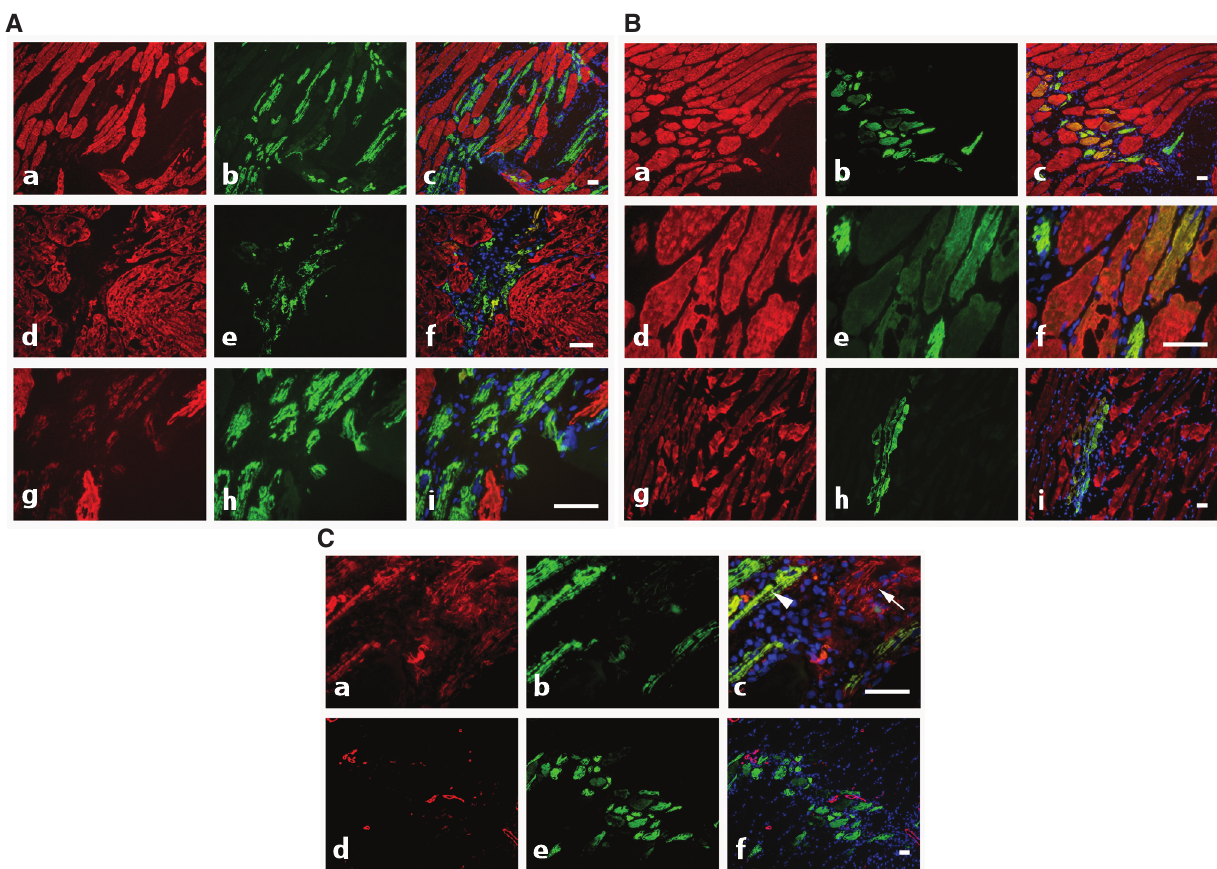
Figure 3. Regenerating rat adult skeletal muscle co-stained with isoform specific antibodies. A ) At 4d post-injury, co-staining with anti- α -SKA (red) and anti- α -CAA (green) shows the presence of α -CAA positive fibers in the injured muscle area (a–i). At this stage of regeneration, only a few fibers co-express both isoforms (d–i), with a low α -SKA level (g–i). Merged images are shown on right column. Bars = 50 μm. B ) At 5d–9d post-injury, co-staining with anti- α -SKA (red) and anti- α -CAA (green) shows that after 5d, most fibers co-express both isoforms (a–f), whereas at 9d (g–i), α -SKA positive fibers become predominant. Merged images are shown on right column. Bars = 50 μm. C ) At 4d–5d post-injury, co-staining with anti- α -SMA (red) and anti- α -CAA (green) shows that during the healing process, only a few fibers co-express both isoforms after 4d (a–c, arrowhead), whereas after 5d, only α -CAA positive fibers are detected (d–f). After 4d, myofibroblasts might participate to the repair process and are detected by using the anti- α - SMA mAb (a–c, arrow). Merged images are shown on right column. Bars = 50